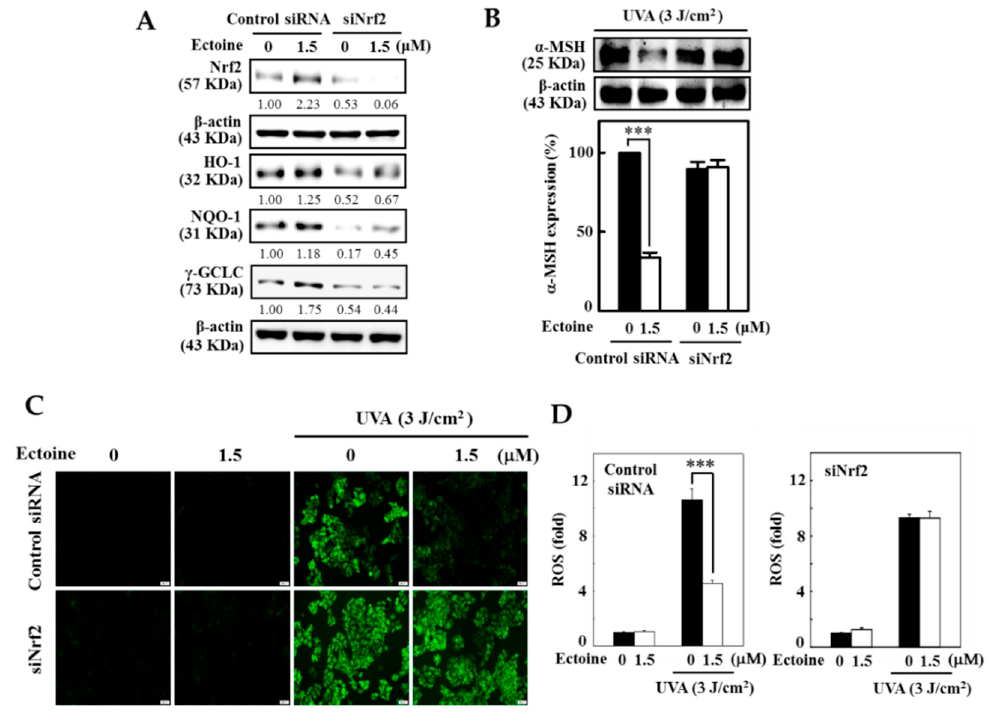
Figure 7. Nrf2 knockdown attenuated the protective effects of Ectoine in UVA-irradiated HaCaT cells. Cells were transfected with siRNA that is specific to either Nrf2 or a non-silencing control. ( A ) Transfected cells were pre-treated with Ectoine (0 or 1.5 μ M for 2 or 12 h) and the expression of Nrf2 (for 2 h), or HO-1, NQO-1, and γ -GCLC (for 12 h) proteins in both control and siNrf2 were measured by Western blot analysis. ( B ) The effect of Nrf2 knockdown on the expression of α -MSH levels in UVA irradiated HaCaT cells were determined. Transfected cells were pre-treated with or without Ectoine (1.5 μ M for 24 h) and then irradiated with 3 J/cm 2 UVA. The Western blot method measured the percentage of α -MSH levels ( C , D ) The effect of Nrf2 knockdown on the UVA radiation-induced ROS levels in transfected cells were measured by DCF fluorescence microscopy. Statistical significance was assigned as *** p < 0.001 compared to the untreated cells.